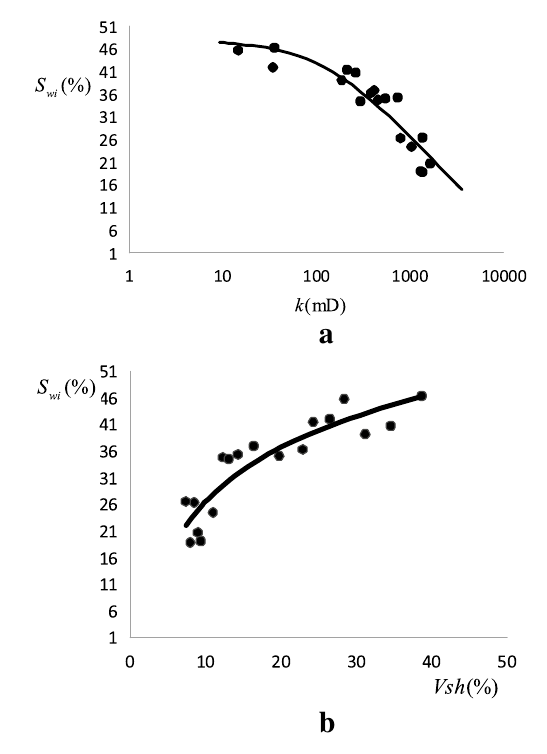
Fig. 4 a Correlation diagram of permeability ( k ) and bound water saturation ( S wi ), b correlation diagram of shale content ( V sh ) and bound water saturation ( S wi )